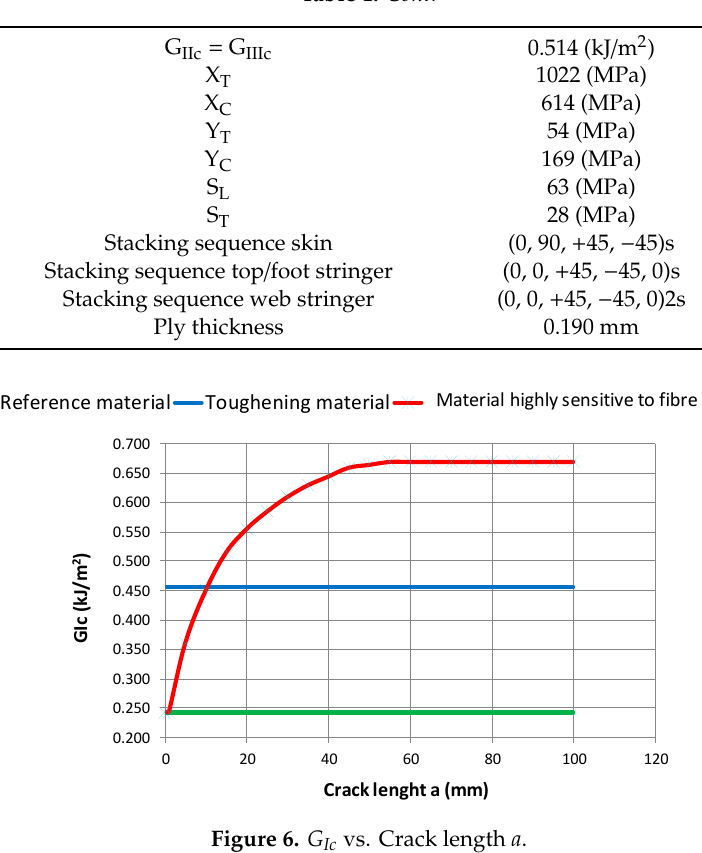
Figure 6. G Ic vs. Crack length a .